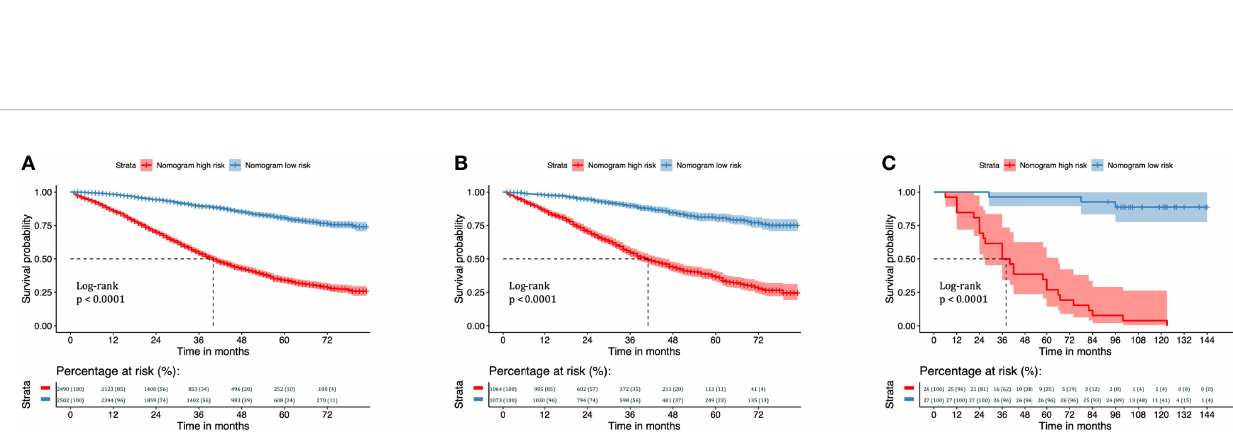
FIGURE 7 | External validation of the nomogram compared with AJCC stage in 53 cases of EOC from Shengjing Hospital. AUC curves of the nomogram and AJCC stage in the prediction of prognosis at the 1- (A) , 3- (B) , and 5-year (C) points.